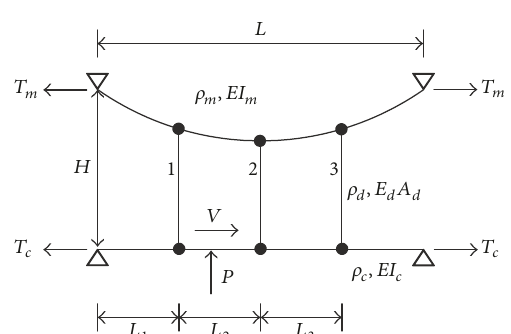
Figure 11: A simple stitched catenary structure with three nonlinear droppers subjected to a moving force.